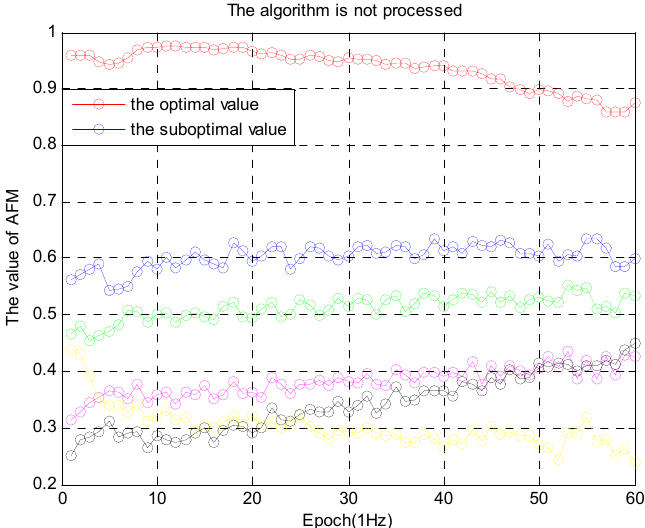
Figure 8. Algorithm after not-processing.